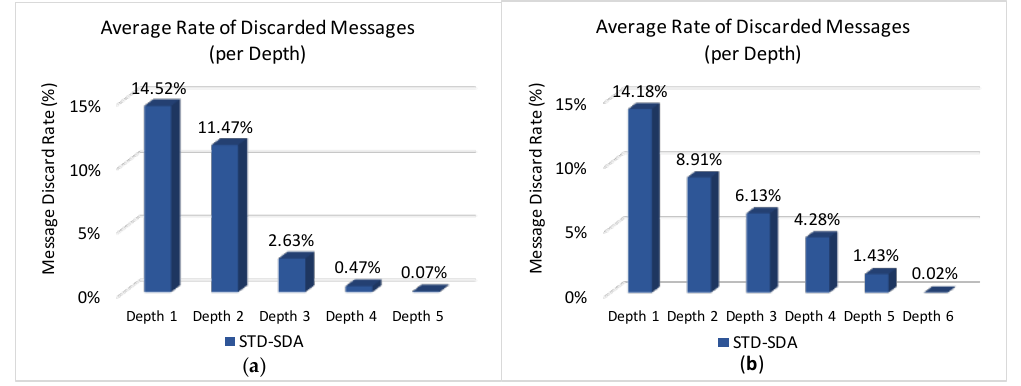
Figure 15. Average message discard rate (per depth) due to buffer overflows for the STD-SDA scheme: ( a ) Unconditioned Scenario; ( b ) Conditioned